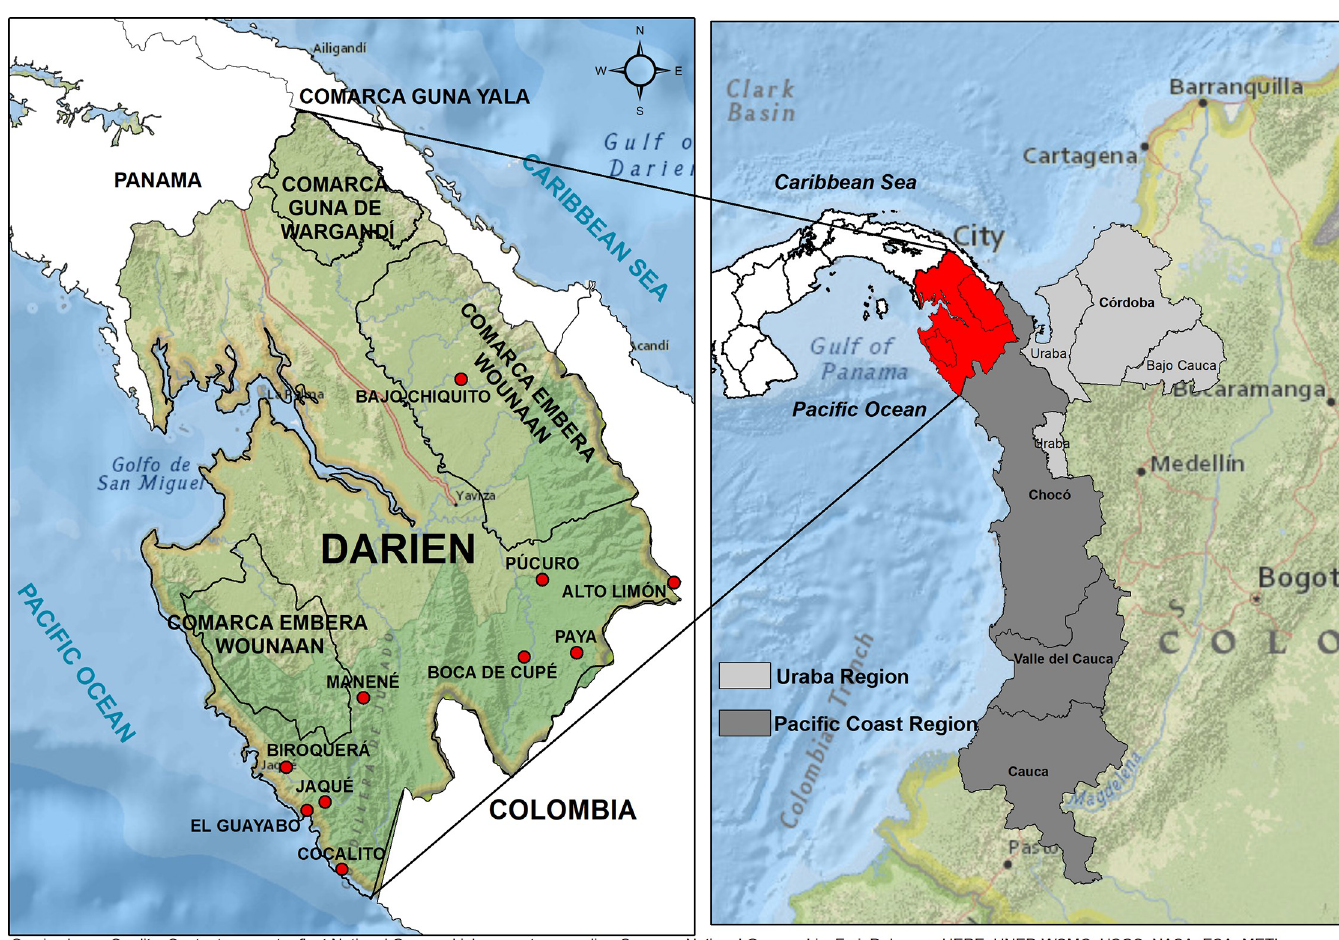
Fig 6. Geographical location of bordering communities in Darie´n region. These communities maintain an active interaction and migration activity with malaria endemic regions of Colombia.